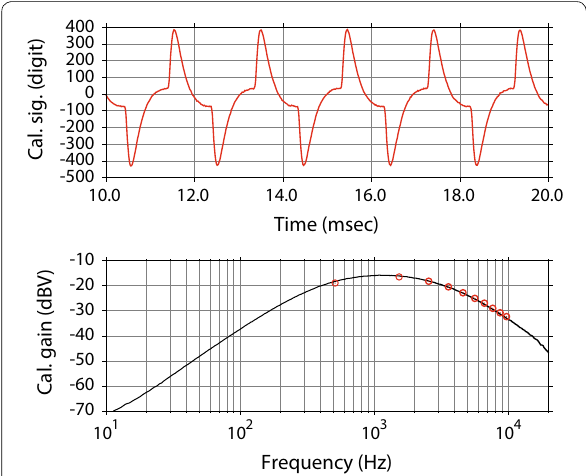
Fig. 13 Example of the onboard calibration result of the B γ compo- nent. The upper panel is the waveform obtained at 23:39 UT, March 10, 2017, by the WFC for applied square pulses having a fundamen- tal frequency of 512 Hz. The bottom panel shows the gain of the onboard calibration (dots) at the fundamental frequency and its harmonics. The black line indicates the gain measured by a laboratory experiment for